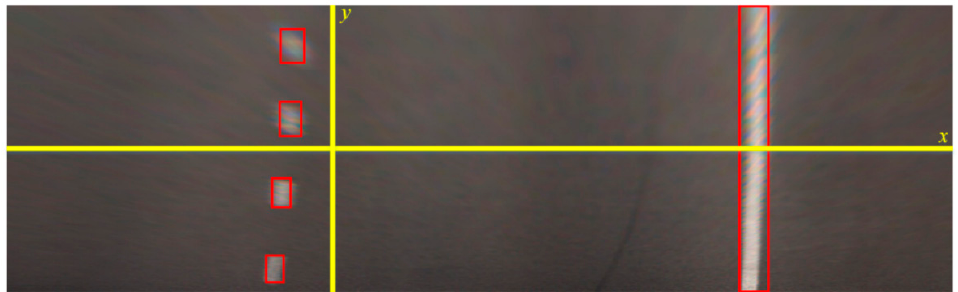
Figure 2. Lane distribution in the bird-view image.